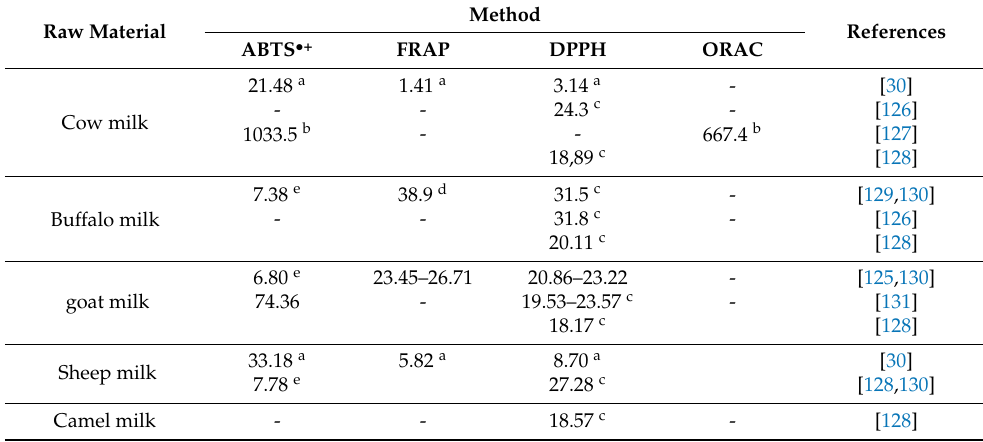
Table 3. Total antioxidant capacity (TAC) of raw milk (own work based on: [30,125–130]). Raw